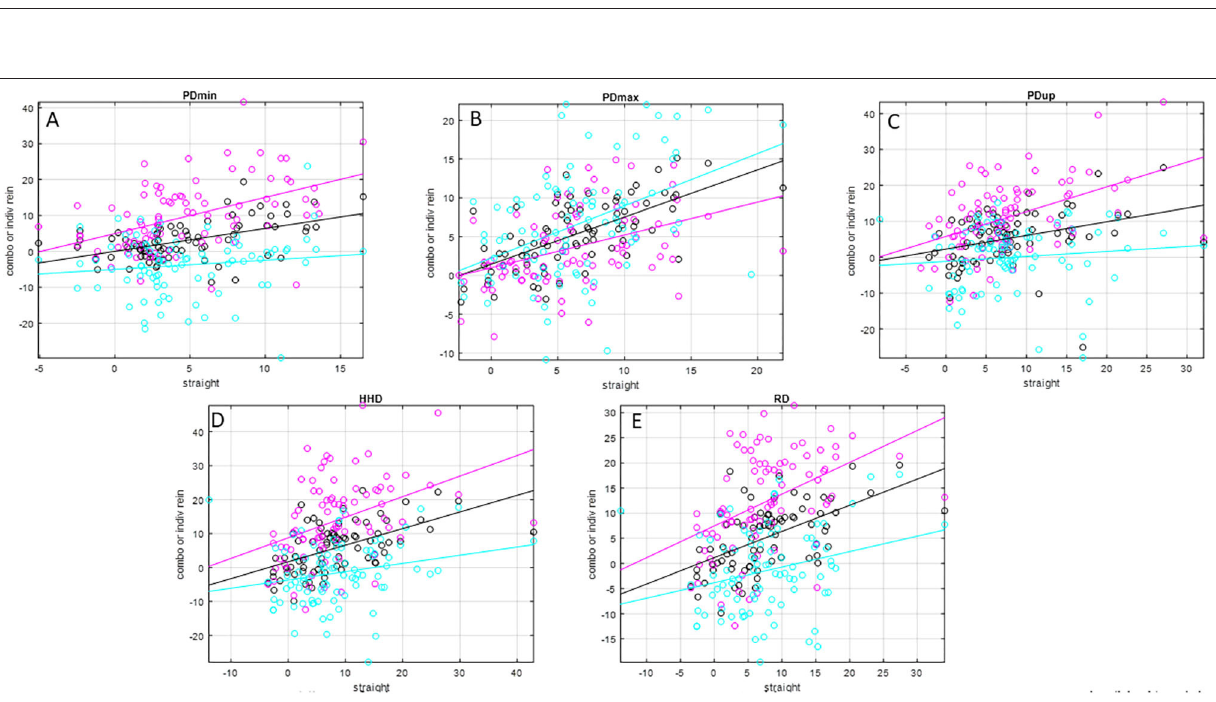
FIGURE 1 | Scatter plots and linear trend lines of pairs of matching straight-line and individual rein (inside rein: magenta; outside rein: cyan), average-rein (black) head and withers movement asymmetry values (in mm) for N = 79 pairs of asymmetry values for N = 26 horses (one horse did not have matching straight-line and average-rein asymmetry values). Please see Table 2 for values of slope, intercept, and R 2 values. (A) HDmin, (B) HDmax, (C) HDup, (D) WDmin, (E) WDmax, (F) WDup.